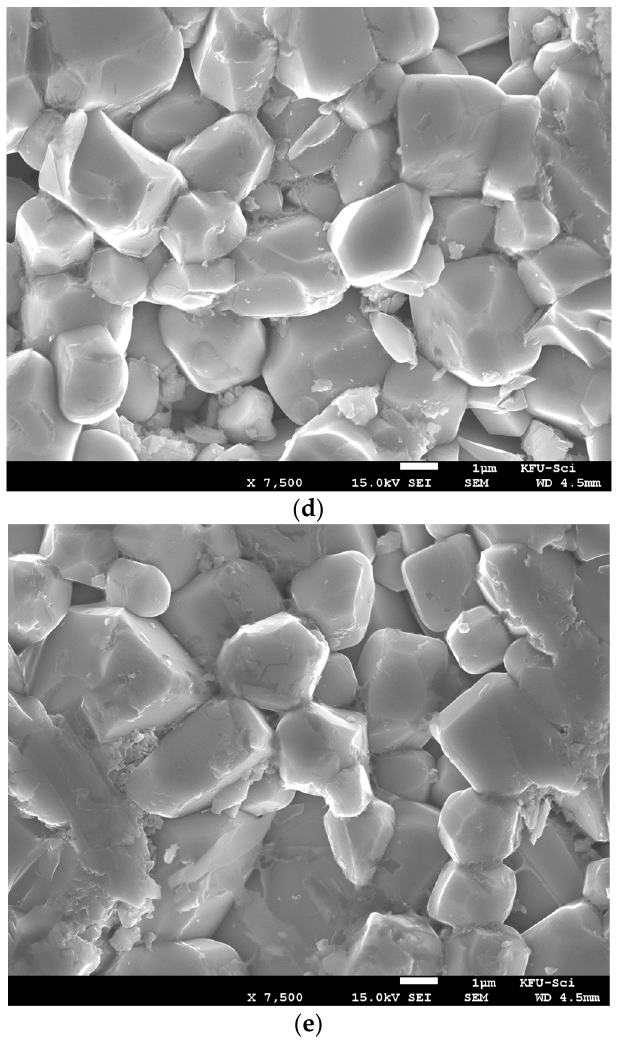
Figure 2. FE-SEM micrographs of ( a ) powder, ( b ) CS-1000, ( c ) CS-1025, ( d ) CS-1075, and ( e ) CS-1100 samples.